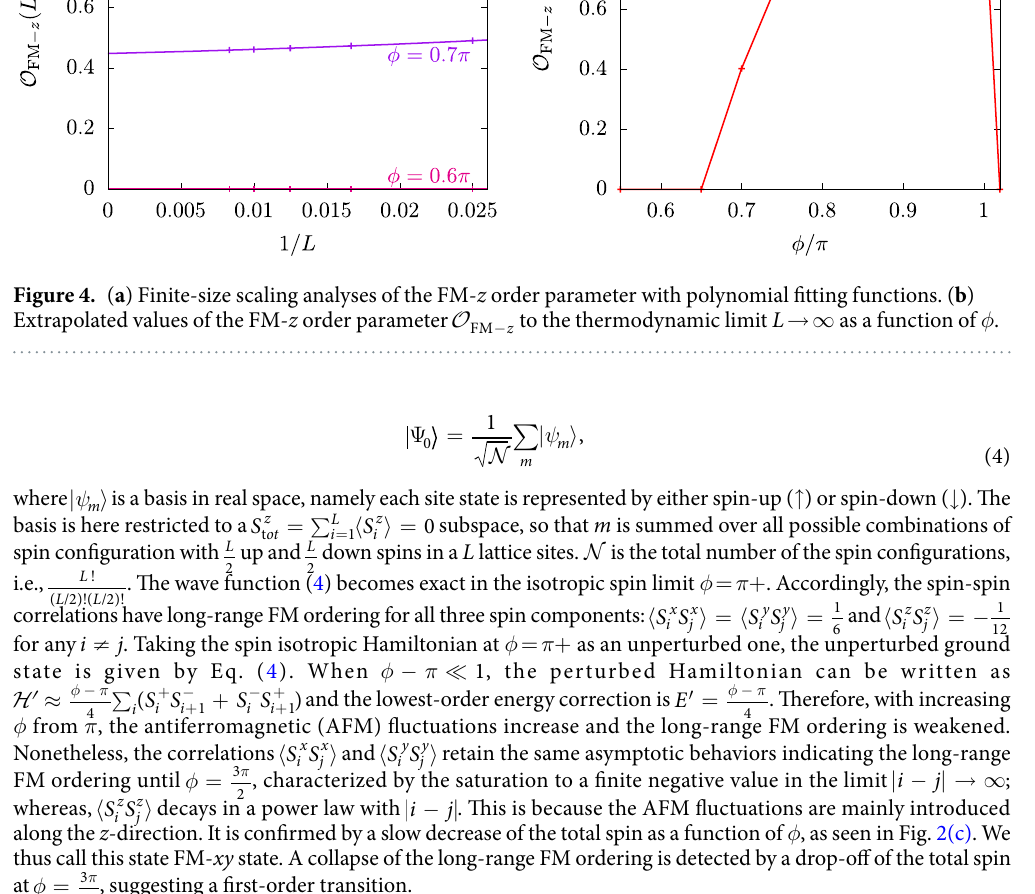
to the thermodynamic limit L → ∞ as a function of φ z FM